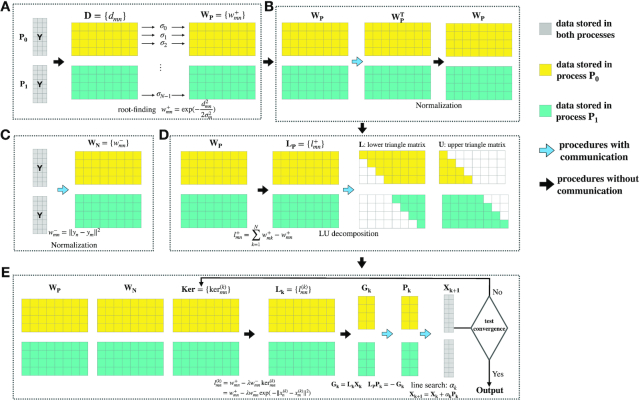
Overview of D-EE algorithm. The D-EE algorithm can be decomposed into 5 parts. Part A: the computation of matrices \documentclass[12pt]{minimal}
\usepackage{amsmath}
\usepackage{wasysym}
\usepackage{amsfonts}
\usepackage{amssymb}
\usepackage{amsbsy}
\usepackage{upgreek}
\usepackage{mathrsfs}
\setlength{\oddsidemargin}{-69pt}
\begin{document}
}{}$\mathbf {D}$\end{document} and \documentclass[12pt]{minimal}
\usepackage{amsmath}
\usepackage{wasysym}
\usepackage{amsfonts}
\usepackage{amssymb}
\usepackage{amsbsy}
\usepackage{upgreek}
\usepackage{mathrsfs}
\setlength{\oddsidemargin}{-69pt}
\begin{document}
}{}$\mathbf {W_P}$\end{document}. To obtain \documentclass[12pt]{minimal}
\usepackage{amsmath}
\usepackage{wasysym}
\usepackage{amsfonts}
\usepackage{amssymb}
\usepackage{amsbsy}
\usepackage{upgreek}
\usepackage{mathrsfs}
\setlength{\oddsidemargin}{-69pt}
\begin{document}
}{}$\mathbf {W_P}$\end{document}, the parameters {σn} are determined by solving a series of root-finding problems. Part B: the symmetry and normalization of the matrix \documentclass[12pt]{minimal}
\usepackage{amsmath}
\usepackage{wasysym}
\usepackage{amsfonts}
\usepackage{amssymb}
\usepackage{amsbsy}
\usepackage{upgreek}
\usepackage{mathrsfs}
\setlength{\oddsidemargin}{-69pt}
\begin{document}
}{}$\mathbf {W_P}$\end{document}. Part C: the computation and normalization of \documentclass[12pt]{minimal}
\usepackage{amsmath}
\usepackage{wasysym}
\usepackage{amsfonts}
\usepackage{amssymb}
\usepackage{amsbsy}
\usepackage{upgreek}
\usepackage{mathrsfs}
\setlength{\oddsidemargin}{-69pt}
\begin{document}
}{}$\mathbf {W_N}$\end{document}. Part D: the computation of the Laplacian matrix \documentclass[12pt]{minimal}
\usepackage{amsmath}
\usepackage{wasysym}
\usepackage{amsfonts}
\usepackage{amssymb}
\usepackage{amsbsy}
\usepackage{upgreek}
\usepackage{mathrsfs}
\setlength{\oddsidemargin}{-69pt}
\begin{document}
}{}$\mathbf {L_P}$\end{document} together with LU decomposition. Part E: the computation of \documentclass[12pt]{minimal}
\usepackage{amsmath}
\usepackage{wasysym}
\usepackage{amsfonts}
\usepackage{amssymb}
\usepackage{amsbsy}
\usepackage{upgreek}
\usepackage{mathrsfs}
\setlength{\oddsidemargin}{-69pt}
\begin{document}
}{}$\mathbf {X_{k+1}}$\end{document} by solving an optimization problem with the classic Quasi-Newton methods iteratively. In the kth iteration, \documentclass[12pt]{minimal}
\usepackage{amsmath}
\usepackage{wasysym}
\usepackage{amsfonts}
\usepackage{amssymb}
\usepackage{amsbsy}
\usepackage{upgreek}
\usepackage{mathrsfs}
\setlength{\oddsidemargin}{-69pt}
\begin{document}
}{}$\mathbf {L_k}$\end{document} is computed on the basis of \documentclass[12pt]{minimal}
\usepackage{amsmath}
\usepackage{wasysym}
\usepackage{amsfonts}
\usepackage{amssymb}
\usepackage{amsbsy}
\usepackage{upgreek}
\usepackage{mathrsfs}
\setlength{\oddsidemargin}{-69pt}
\begin{document}
}{}$\mathbf {W_P, W_N}$\end{document}, and \documentclass[12pt]{minimal}
\usepackage{amsmath}
\usepackage{wasysym}
\usepackage{amsfonts}
\usepackage{amssymb}
\usepackage{amsbsy}
\usepackage{upgreek}
\usepackage{mathrsfs}
\setlength{\oddsidemargin}{-69pt}
\begin{document}
}{}$\mathbf {X_k}$\end{document}, which are used to obtain the gradient \documentclass[12pt]{minimal}
\usepackage{amsmath}
\usepackage{wasysym}
\usepackage{amsfonts}
\usepackage{amssymb}
\usepackage{amsbsy}
\usepackage{upgreek}
\usepackage{mathrsfs}
\setlength{\oddsidemargin}{-69pt}
\begin{document}
}{}$\mathbf {G_k = L_kX_k}$\end{document}. The descent direction \documentclass[12pt]{minimal}
\usepackage{amsmath}
\usepackage{wasysym}
\usepackage{amsfonts}
\usepackage{amssymb}
\usepackage{amsbsy}
\usepackage{upgreek}
\usepackage{mathrsfs}
\setlength{\oddsidemargin}{-69pt}
\begin{document}
}{}$\mathbf {P_k}$\end{document} is then determined by solving a linear system \documentclass[12pt]{minimal}
\usepackage{amsmath}
\usepackage{wasysym}
\usepackage{amsfonts}
\usepackage{amssymb}
\usepackage{amsbsy}
\usepackage{upgreek}
\usepackage{mathrsfs}
\setlength{\oddsidemargin}{-69pt}
\begin{document}
}{}$\mathbf {L_PP_k=-G_k}$\end{document}. Finally, \documentclass[12pt]{minimal}
\usepackage{amsmath}
\usepackage{wasysym}
\usepackage{amsfonts}
\usepackage{amssymb}
\usepackage{amsbsy}
\usepackage{upgreek}
\usepackage{mathrsfs}
\setlength{\oddsidemargin}{-69pt}
\begin{document}
}{}$\mathbf {X_{k+1}}$\end{document} is updated according to \documentclass[12pt]{minimal}
\usepackage{amsmath}
\usepackage{wasysym}
\usepackage{amsfonts}
\usepackage{amssymb}
\usepackage{amsbsy}
\usepackage{upgreek}
\usepackage{mathrsfs}
\setlength{\oddsidemargin}{-69pt}
\begin{document}
}{}$\mathbf {X_{k+1}=X_k+}\alpha _k\mathbf {P_k}$\end{document}, where the step size αk is calculated by a line search method.